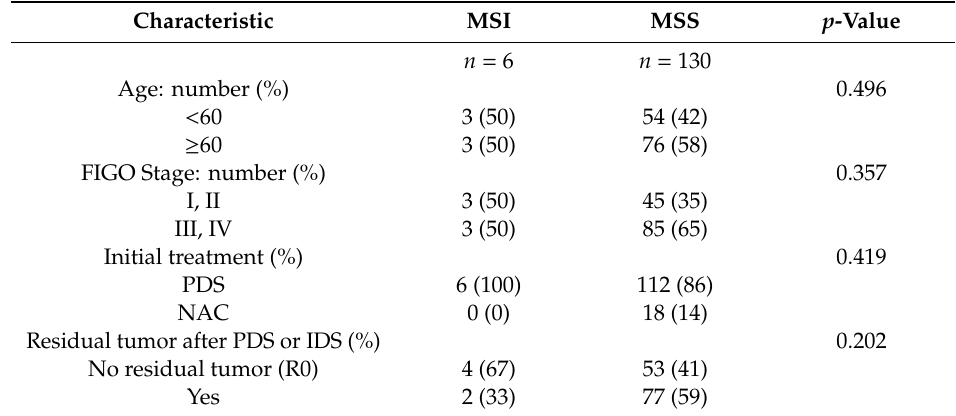
Table 1. Factors in patients with ovarian cancer.